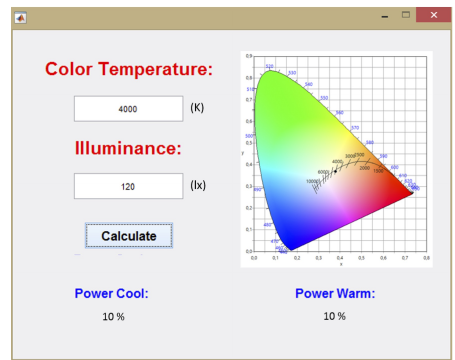
Figure 8. Developed interface to estimate the channels power (cool and warm) as a function of the desired Correlated Color Temperature and illuminance, with the representation of the point in the CIE 1931